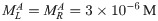
Predicted gene expression profiles for a simple activation architecture.(A) Gene expression for wild type CRP (green dots from Ref. [7]), where 1 Miller Unit (MU) represents a standardized amount of β-galactosidase activity. This data was used to determine the relevant parameters in Eq (14) for the promoter in the presence of [L] = 1.5 μM of CRP [45]. The predicted behavior of the CRP mutants is shown using their corresponding cAMP dissociation constants. (B) The spectrum of possible gene expression profiles can be categorized based upon the cAMP-CRP binding affinity in each subunit. In all cases, we assumed MLA=MRA=3×10-6M and e-βϵintA=0. The activation response (blue) was generated using MLI=MRI=6×10-6M. The repression response (orange) used MLI=MRI=10-7M. The peaked response (gold) used MLI=10-7M and MRI=300×10-6M. The flat response used MLI=MRI=3×10-6M. The remaining parameters in both plots were [P]PD=130×10-6, rtrans=5×105MUhr, γ = 0.1, ϵP,LA=-3kBT, ϵP,LI=0kBT, ϵ = −3kBT, and those shown in Tables 1 and 2.